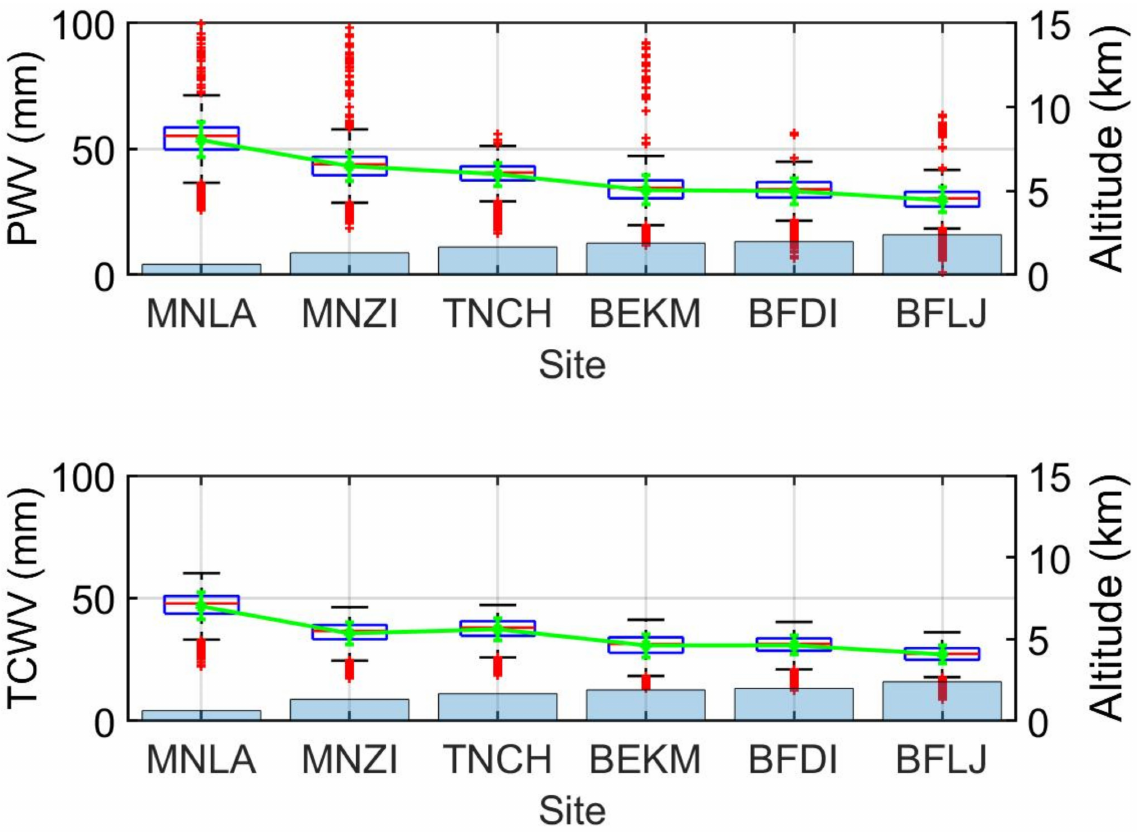
Figure 2. PWV, TCWV, and altitude of 6 stations (box plot: PWV and TCWV; histogram: station altitude; green line: mean value; error bars: standard